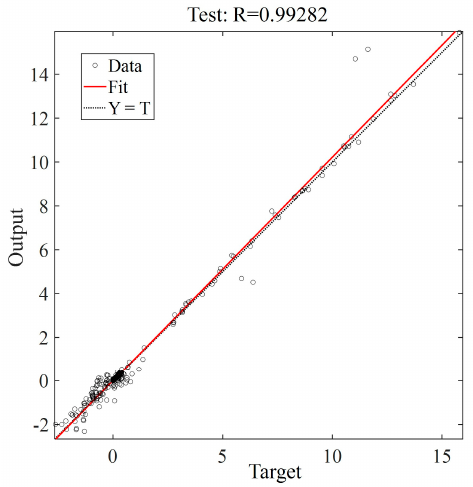
Figure 9. Correlation curve of the RBF test set.